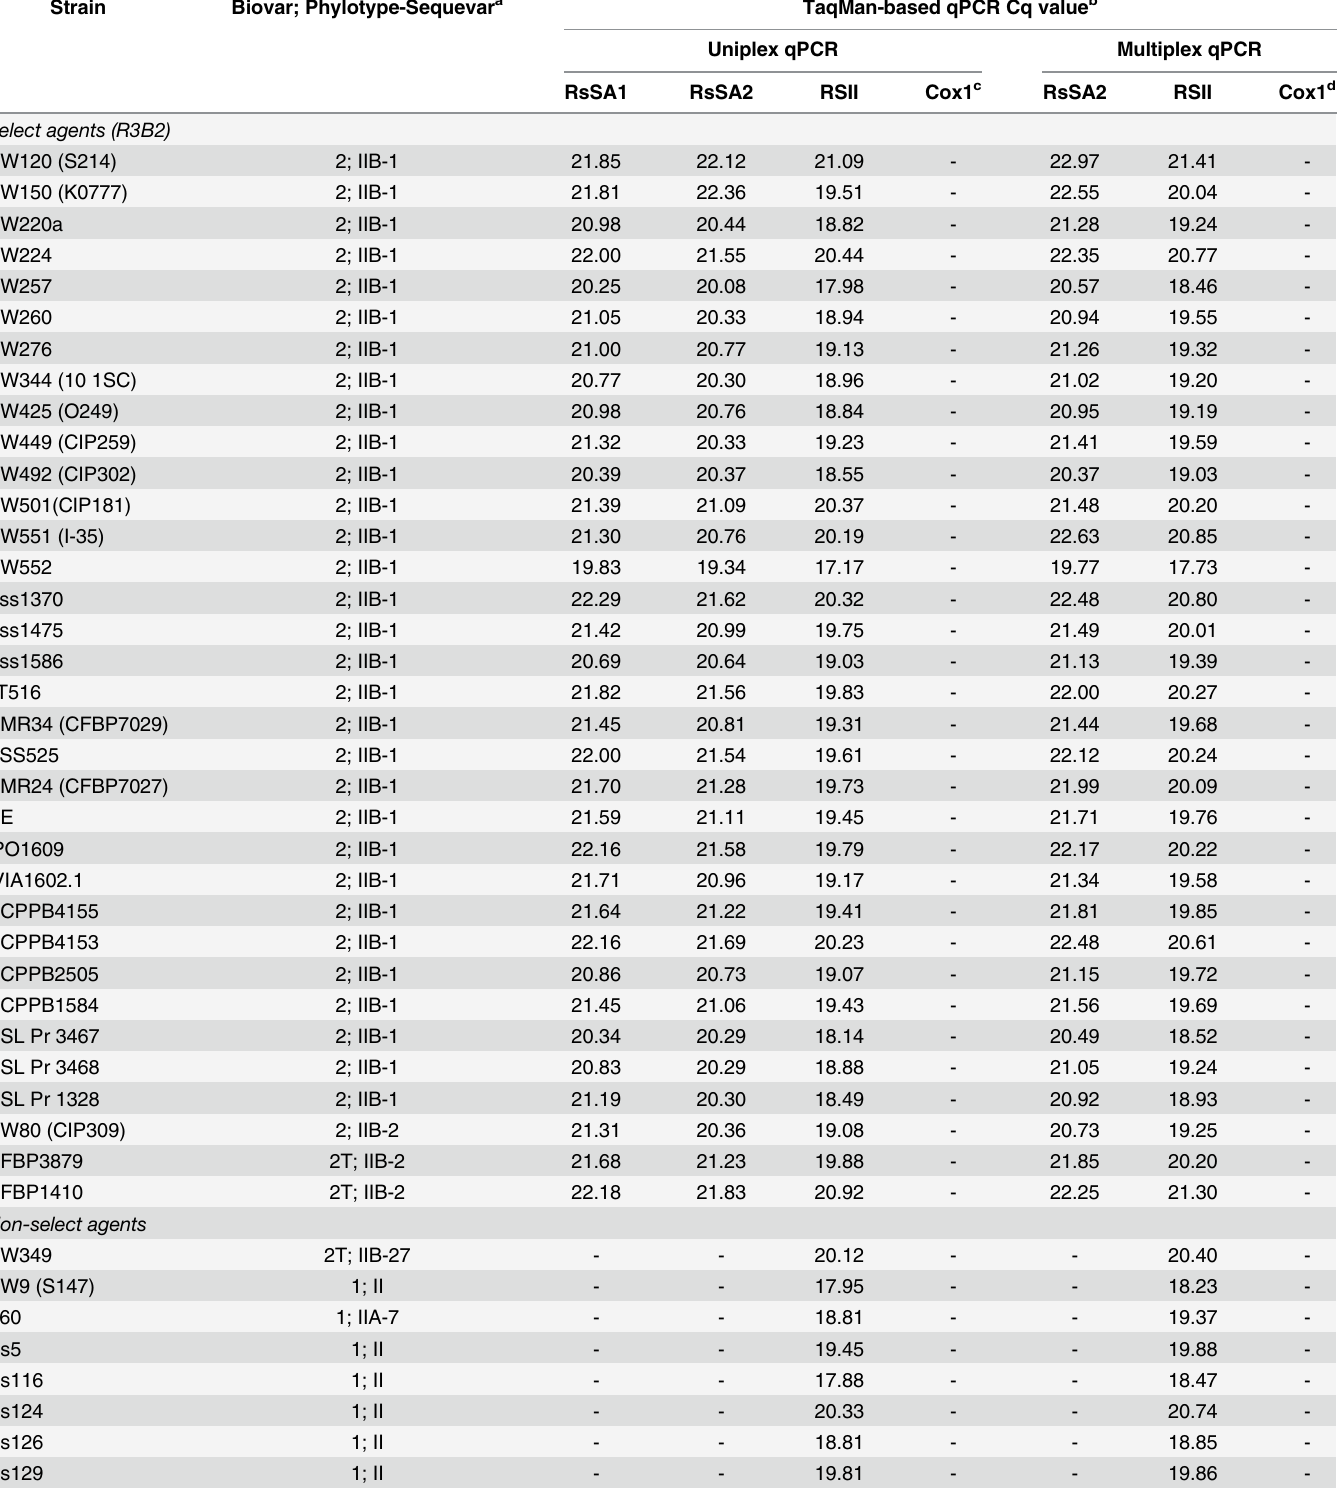
Table 1. Bacterial strains used in this study and tested by our primers and probes, under both uniplex and multiplex qPCR conditions.